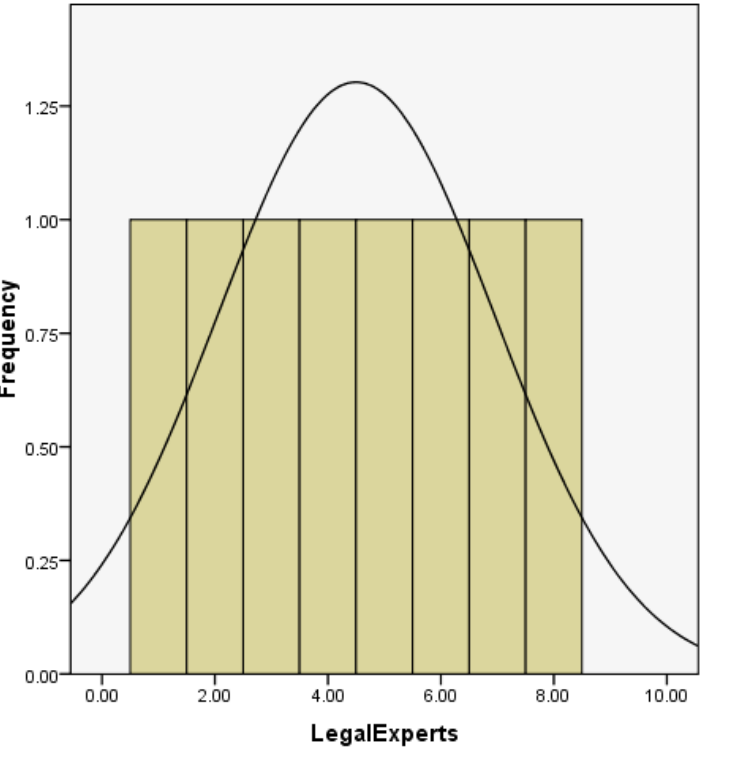
Figure 2. Legal Impact of